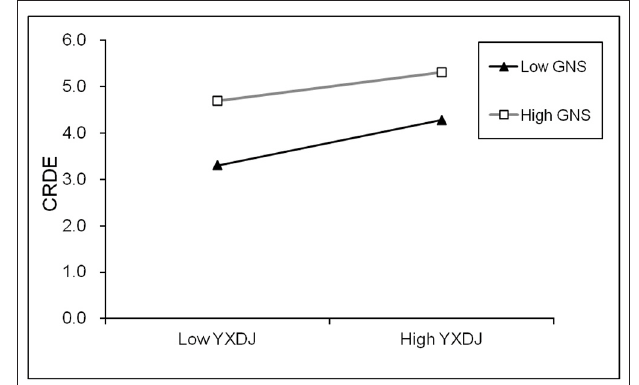
FIGURE 2 | Moderating and interaction effect figure.